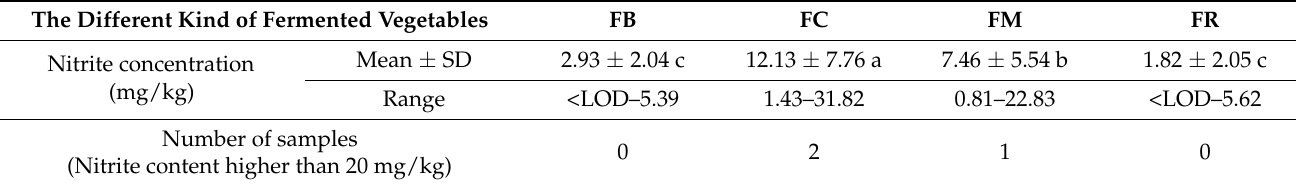
Table 2. Nitrite concentrations in different types of fermented vegetables: FB, fermented bamboo; FC, fermented cabbage; FM, fermented mustard; FR, fermented radish; LOD: limit of detection. Mean ± SD (standard deviation) values in the same row, followed by different letters (a, b, c, etc.) are significantly different (Duncan’s test, p < 0.05). The Different Kind of Fermented Vegetables FB FC Nitrite concentration